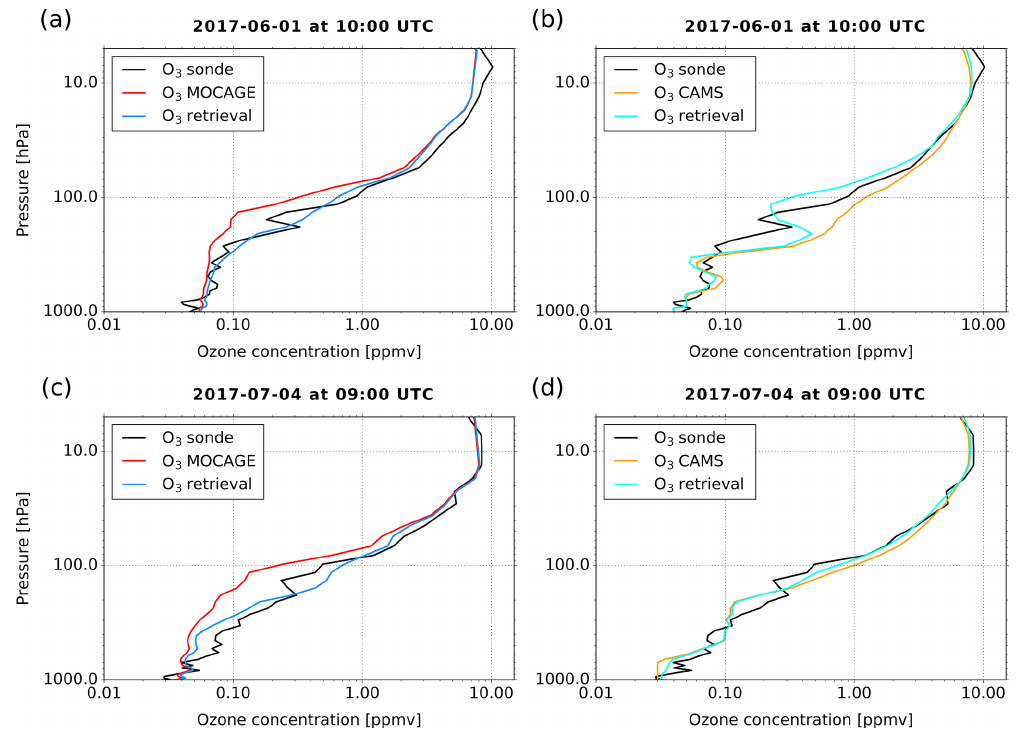
Figure 13. As in Fig. 12, except for IASI for in situ sounding from 1 June at 10:00UTC (b) and 4 July 2017 at 09:00UTC (d) .